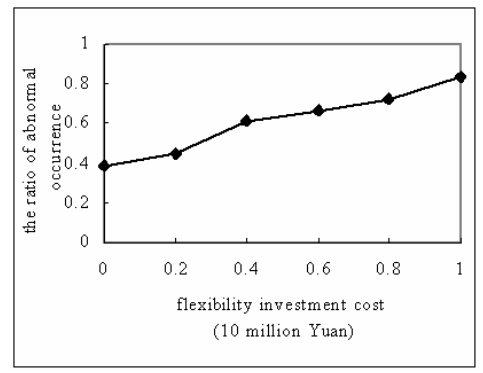
Fig.5. Relationship between flexibility investment cost and the ratio of abnormality